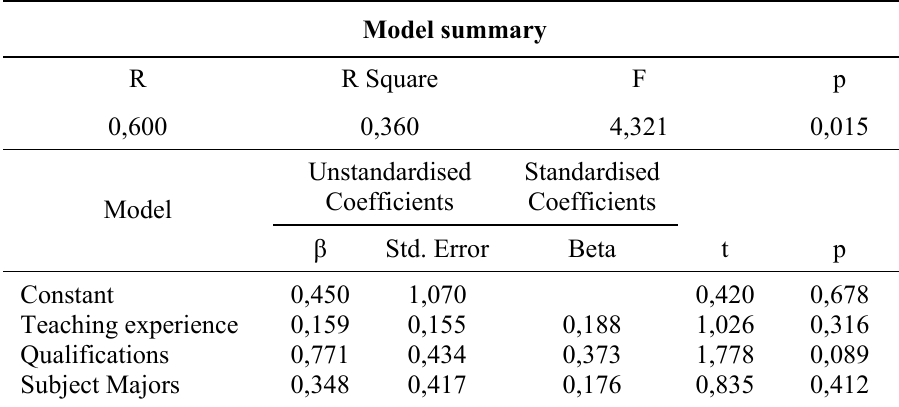
Table 4 : Relationship between the criterion variable (achievement) and the three independent variables (Regression analysis) (N =